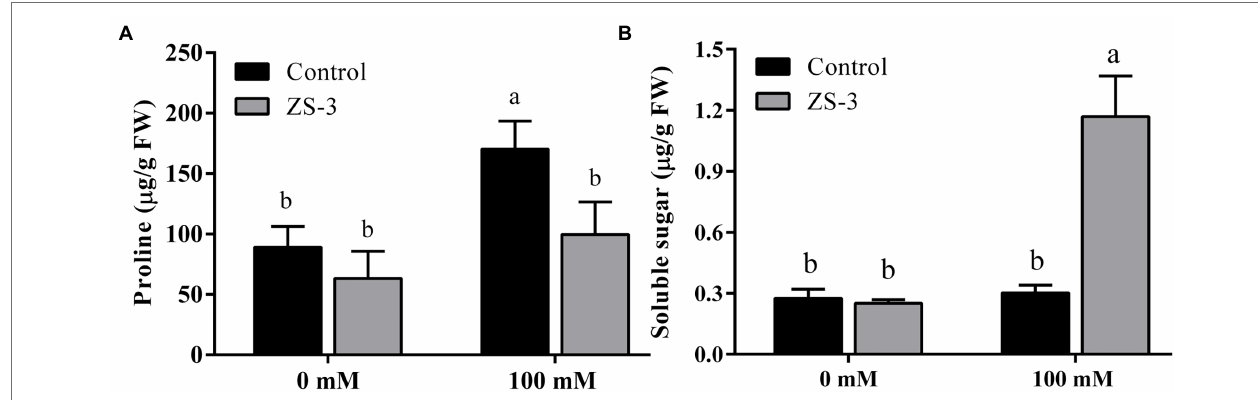
FIGURE 3 | Effect of inoculation with ZS-3 on the proline content (A) and soluble sugar content (B) content of Arabidopsis thaliana . The results are the mean ± standard deviation from three independent experiments. Different lowercase letters above the bars represent significant differences based on one-way ANOVA (Duncan’s multiple range, p <